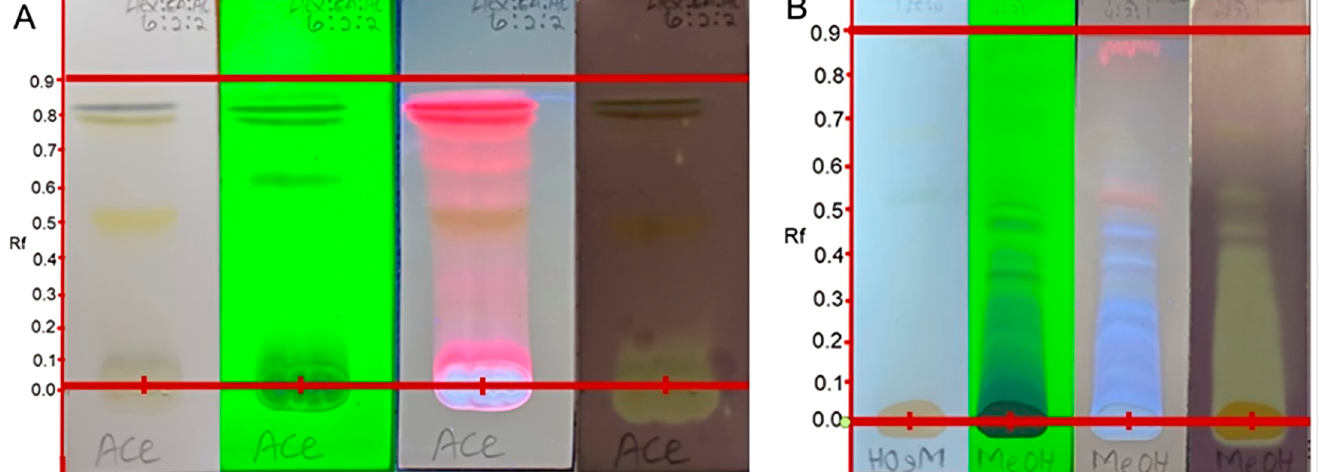
Figure 2. TLC chromatogram of the acetone ( A ) and methanol ( B ) extracts of Mistletoe indicating different phytochemical bands. Plates visualized and snapped at white light (1), 255 nm (2), 366 nm (3) and sprayed with 0.2 mM DPPH solution (4). Table 3. Phytochemical bands present in the polar acetone and methanol extracts of Mistletoe tree.